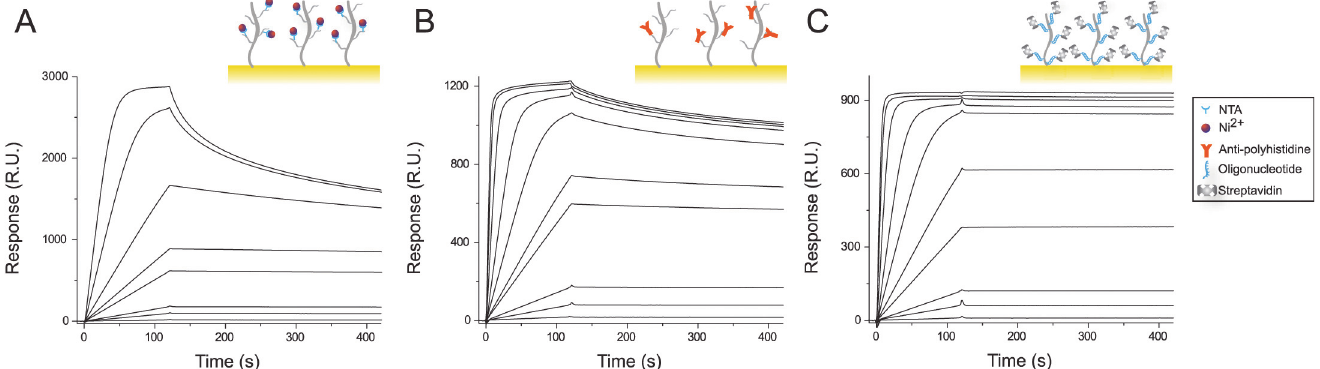
Fig 1. Binding of GFP-Nb to SPR biosensor surfaces. The SPR sensorgrams show the interaction between the GFP-Nb and a NTA surface activated with Ni 2+ ions (A), a CM5 chip functionalized with anti-polyhistidine antibodies (B) and a CAP-chip sensor surface bearing streptavidin free binding sites (C). Depicted sensorgrams were obtained for GFP-Nb concentration of 1, 5, 10, 35, 50, 100, 250, 500, 1000, 1500 nM (from bottom to top curve).